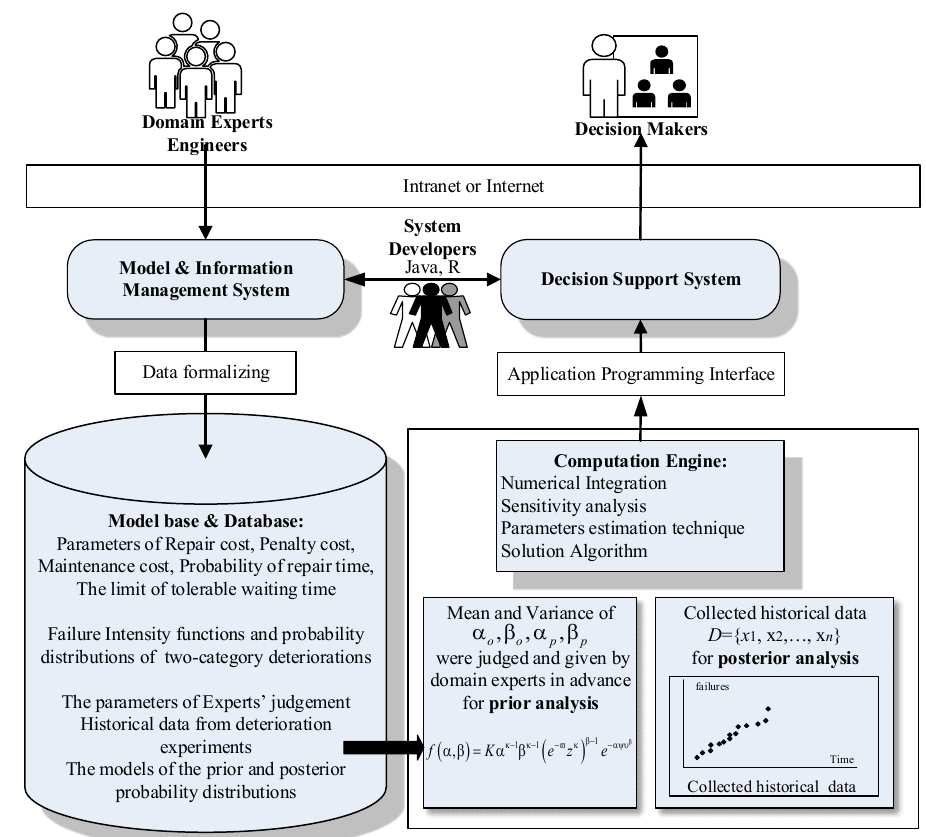
Figure 5. The design of the computerized information system.